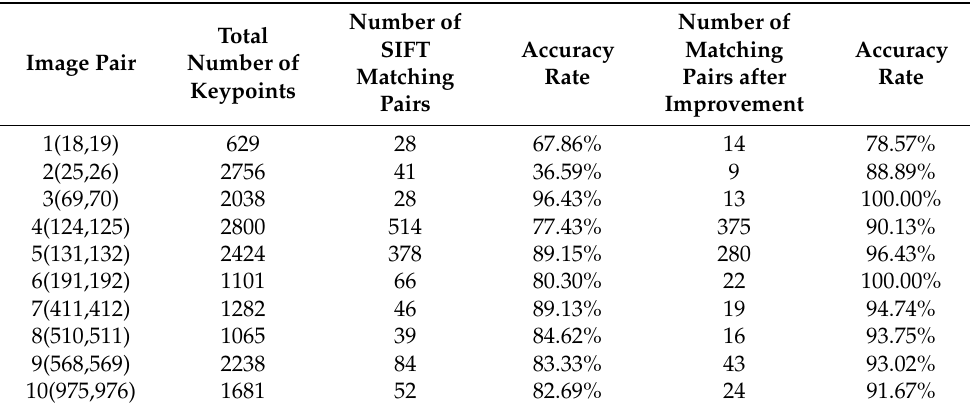
Table 1. Comparison of image pair matching before and after